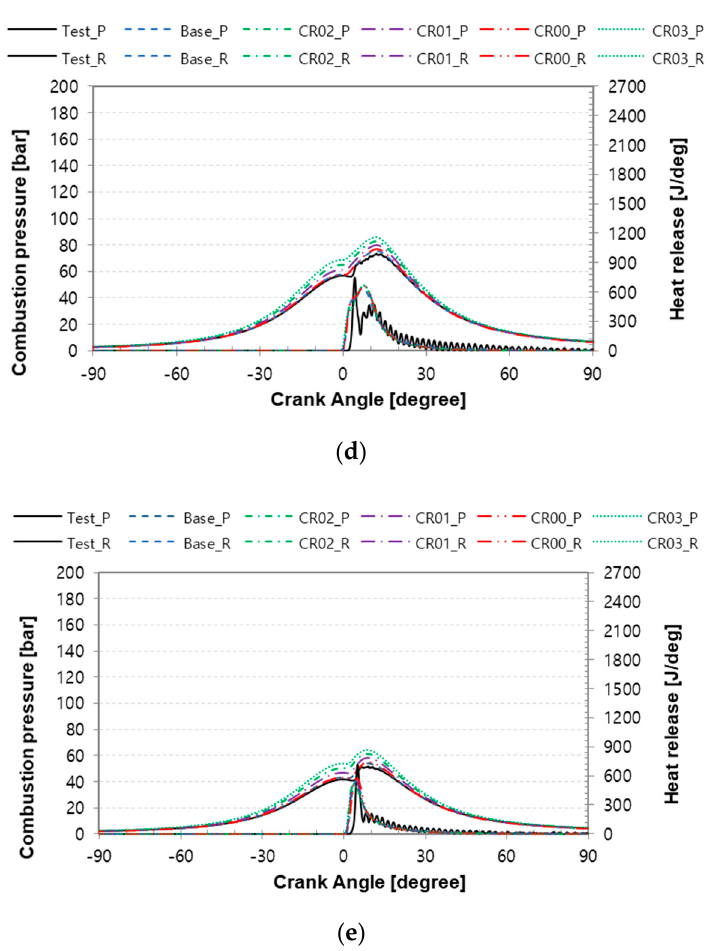
Figure 4. Combustion pressure and heat release characteristics versus the compression ratio of the turbocharger at Emulsified MDO 10%. ( a ) 100% of engine loads ( b ) 75% of engine loads. ( c ) 50% of engine loads. ( d ) 25% of engine loads. ( e ) 10% of engine loads.